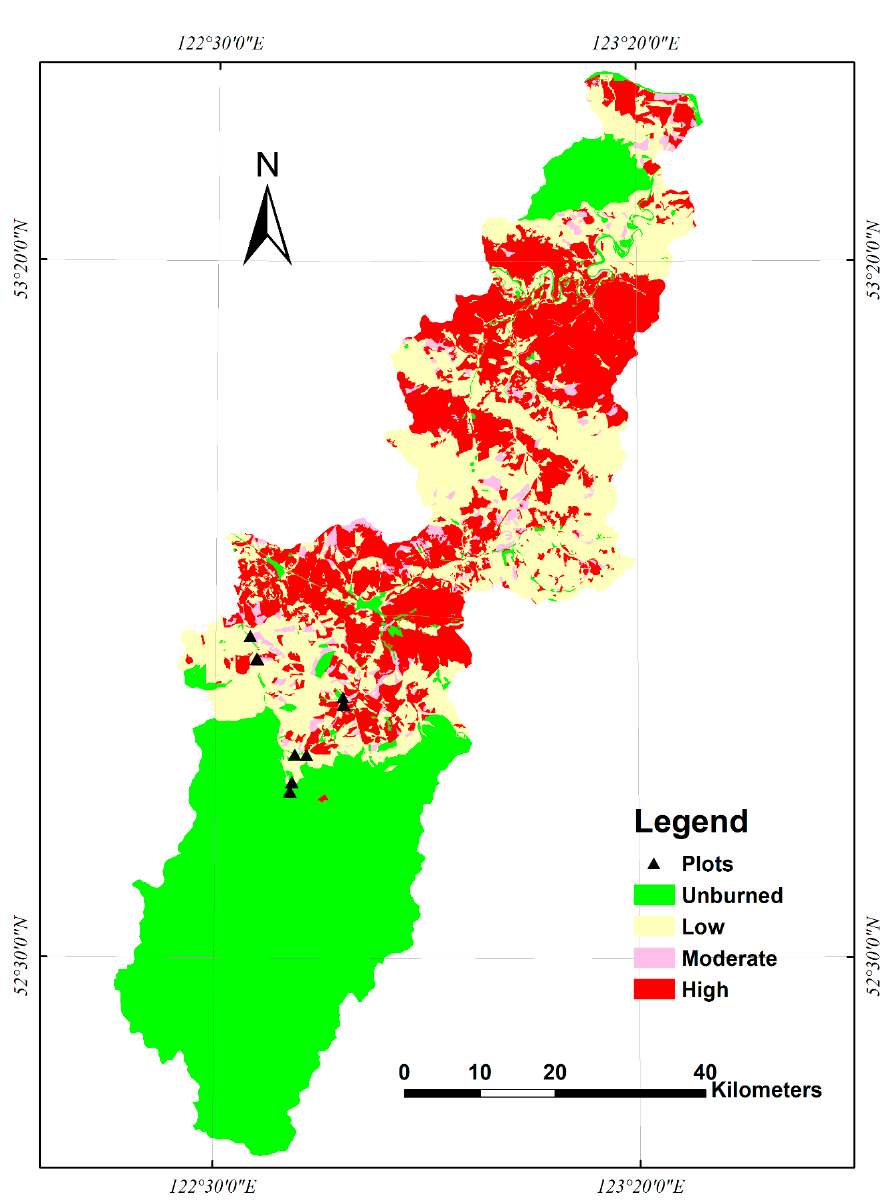
Figure 2. Distribution of forest fire severity and locations of sample plots.